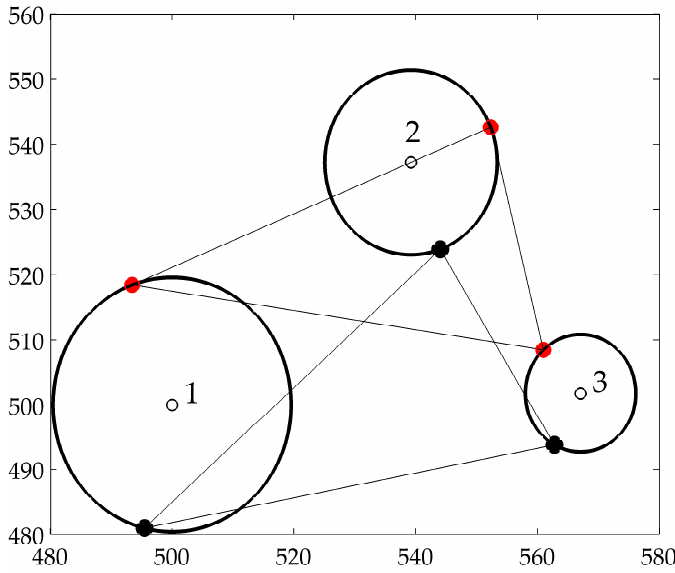
Figure 2. Localization